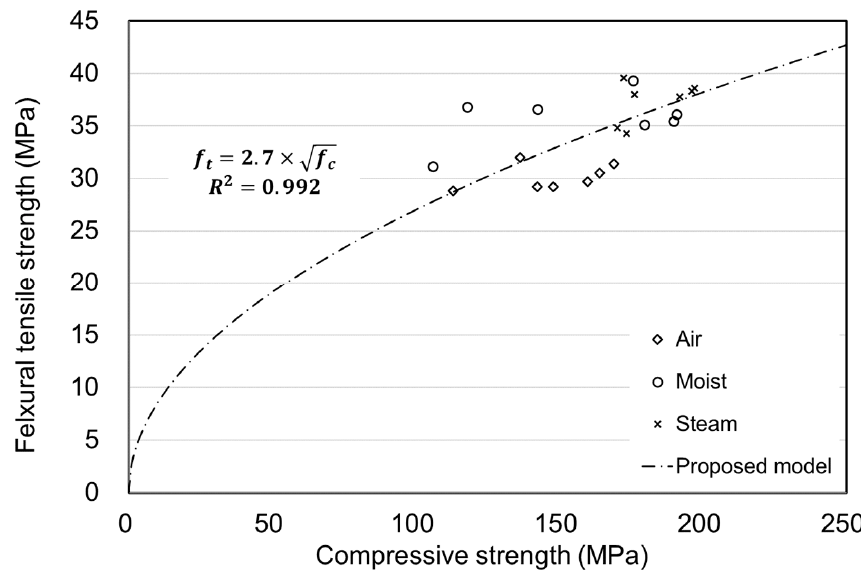
Figure 17. Relationship between flexural tensile and compressive